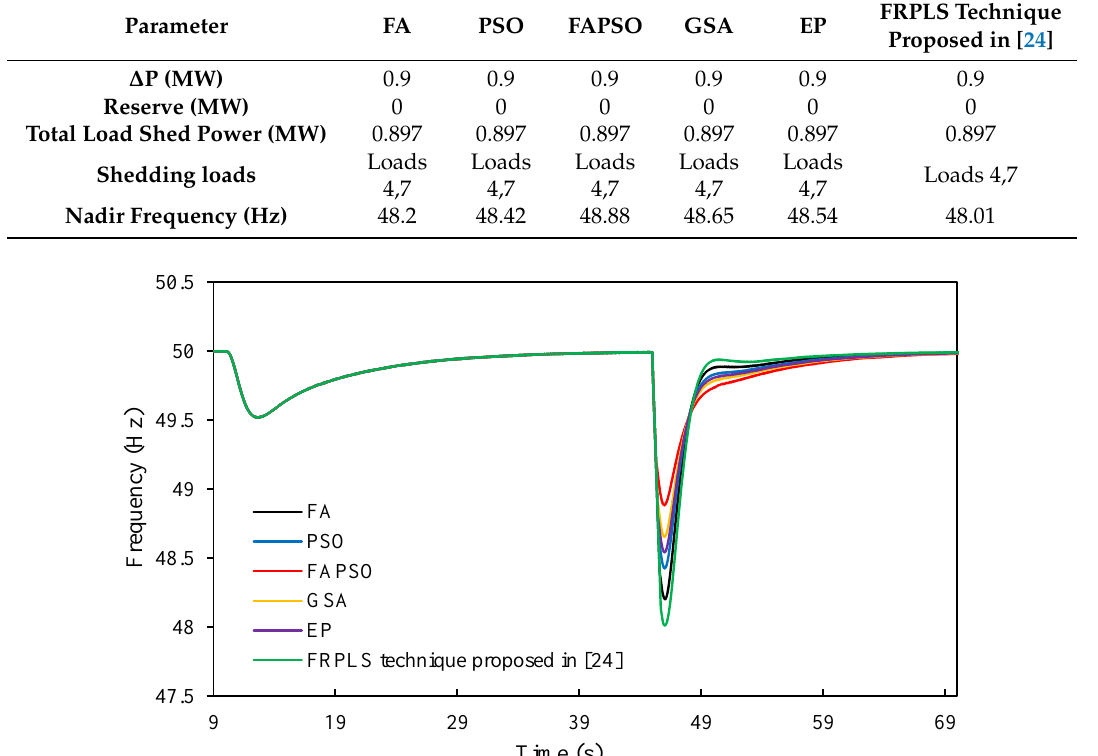
Figure 15. Frequency response for 0.9 MW load increment.